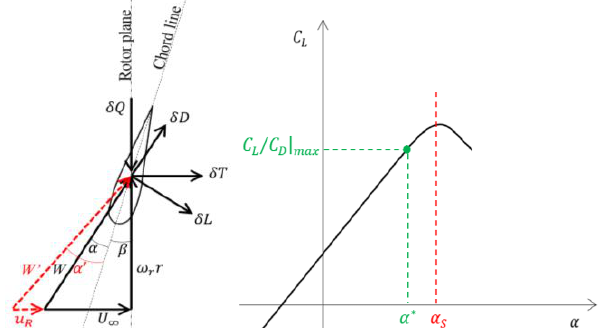
Fig. 12. 2-dimensional sketch (left) of a blade cross-section and a typical lift coefficient over angle of attack curve (right). 𝑢 𝑅 = 𝑥̇(𝑡) = surge velocity, 𝛼 ∗ = design angle of attack, and 𝛼 𝑆 = static stall angle.